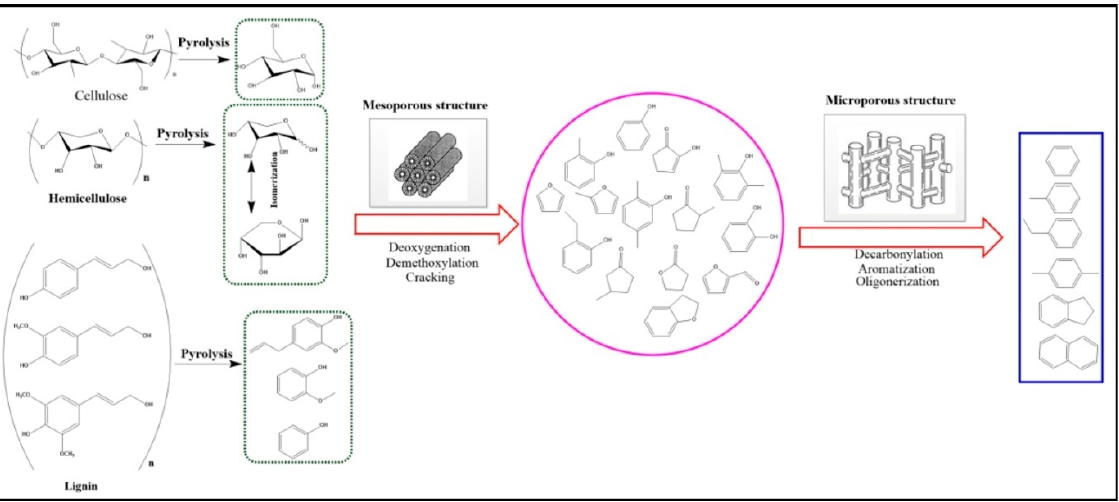
Figure 8. Lignocellulosic reaction path with the help of hierarchical zeolites (Li et al., 2020, Elsevier) [130].